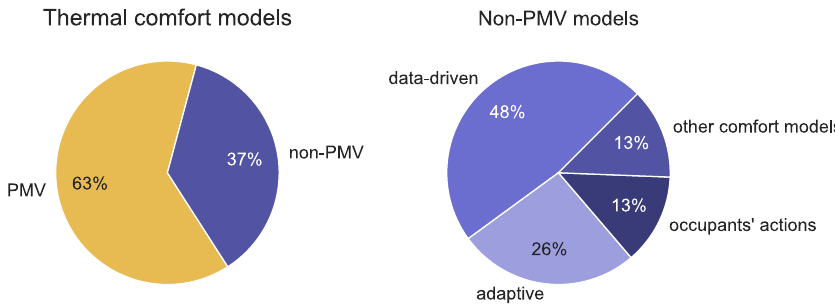
Figure 8. Reviewed documents classified by thermal comfort models: overall ( left ) and breakdown of “non-PMV” sector ( right ).